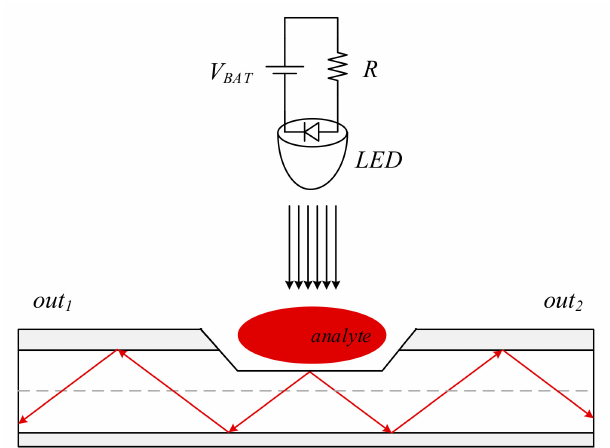
Figure 1. Implementation concept of the proposed intra-oral optical sensor, consisting of an LED source and a D-shaped side-polished optical fiber deployed in a vertical coupler topology, implementing point